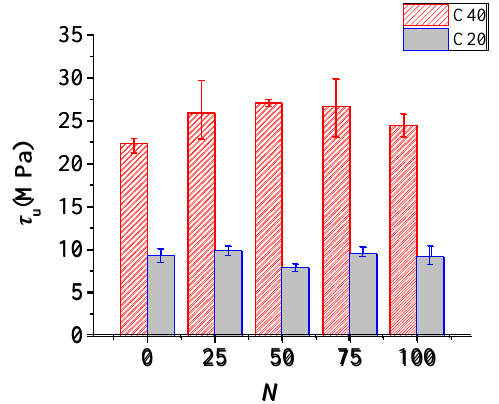
Figure 7. Relationship between ultimate bond strength and N .